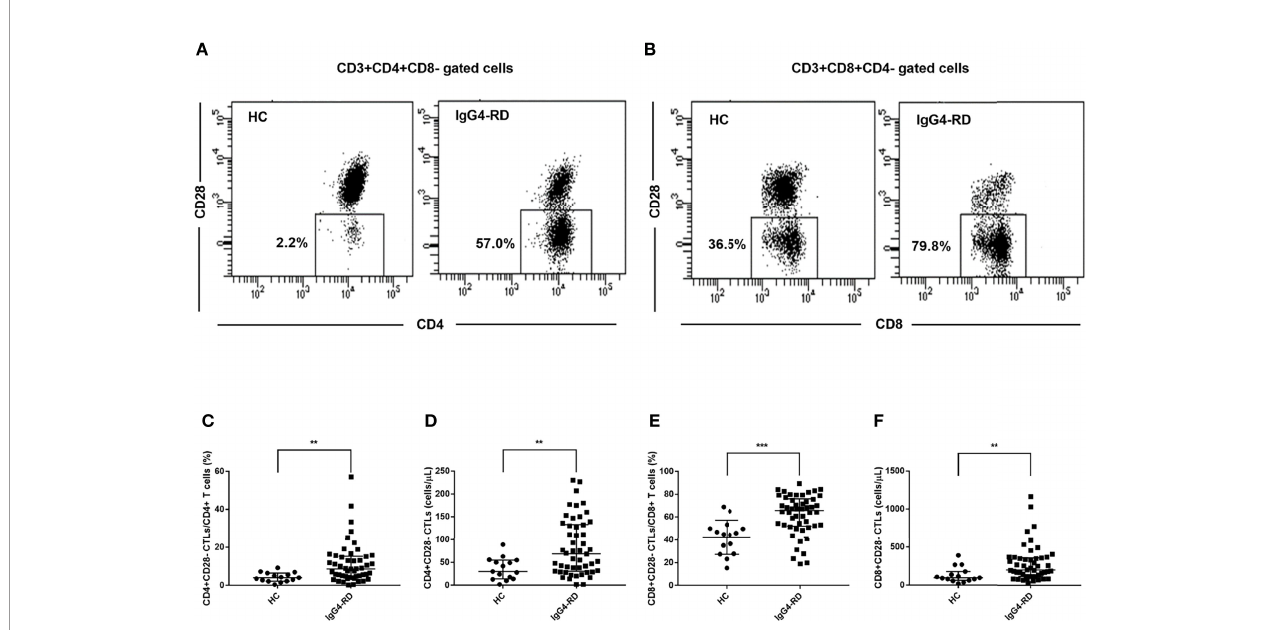
FIGURE 1 | Analysis of the levels of CD28- CTLs in peripheral blood from IgG4-RD patients. Peripheral blood mononuclear cells from IgG4-RD patients ( n = 50) and healthy controls (HCs, n = 15) were extracted and analyzed by fl ow cytometry for the levels of CD4+CD28- and CD8+CD28- CTLs in CD4 and CD8 T cells. (A, B) Representative dot plots of fl ow cytometry analysis. CD4+CD28- CTLs and CD8+CD28- CTLs were gated. (C – F) The levels of circulating CD4+CD28- CTLs and CD8+CD28- CTLs were compared between IgG4-RD patients and HCs. The error bars represented the median with an interquartile range. The two-tailed Mann-Whitney test was used to compare two groups. ** P < 0.01; ∗∗∗ P < 0.001.